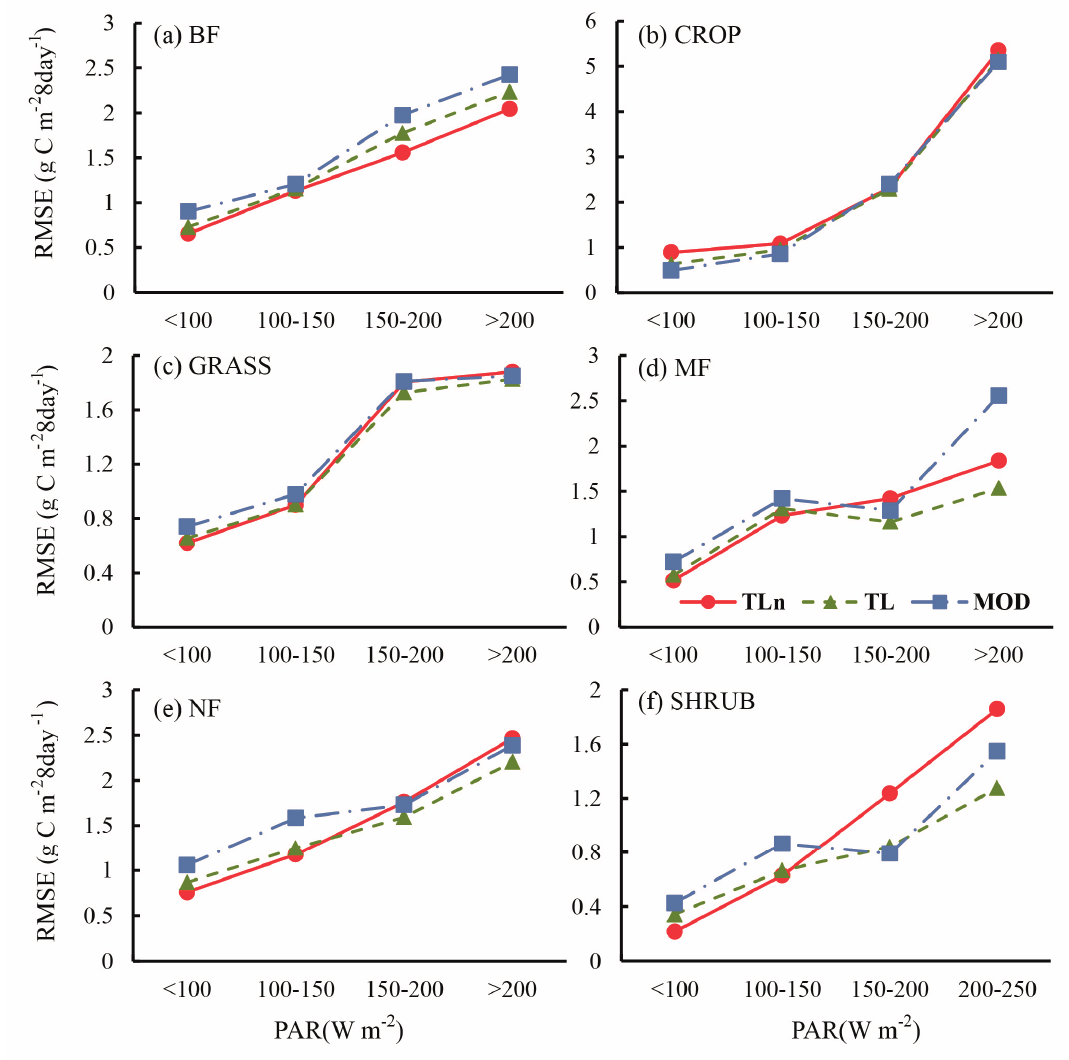
Figure 8. The RMSE of modeled GPP against tower-derived GPP within different PAR classes for 6 different vegetation types: ( a ) BF, ( b ) CROP, ( c ) GRASS, ( d ) MF, ( e ) NF and ( f ) SHRUB, at the 8-day